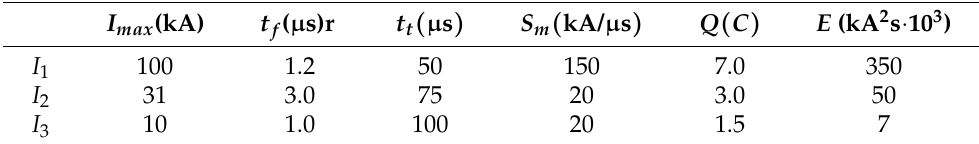
Table 1. Typical lightning current waveshape